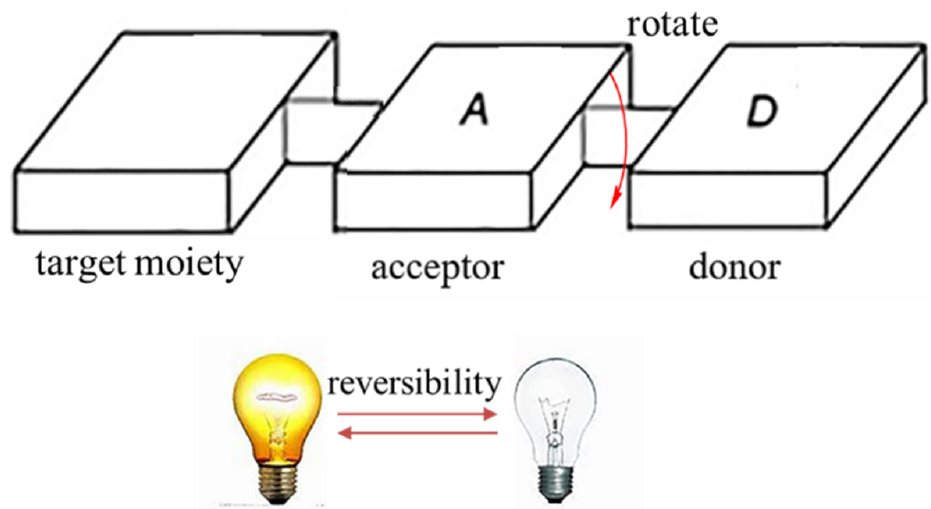
Figure 2. General composition and fluorescent mechanism of rotors.